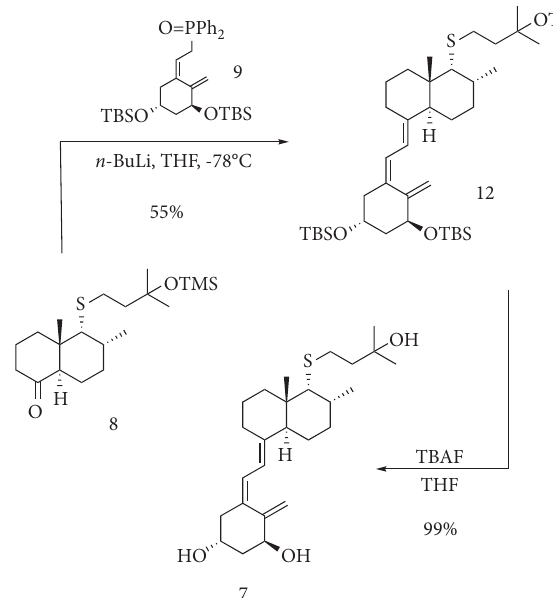
Scheme 5: Obtention of final analogue